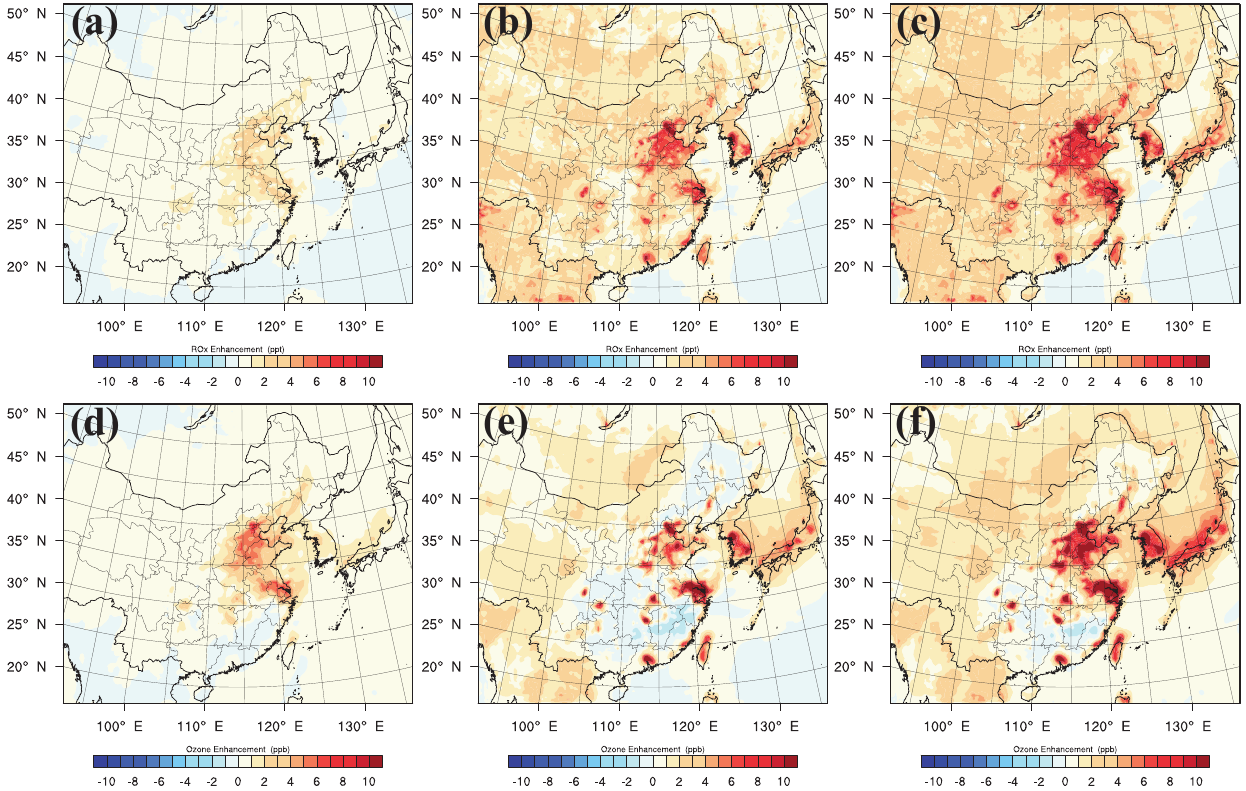
Figure 5. Daytime (06:00–18:00LT) RO x enhancements (ppt) in (a) ReNOM_Cl case, (b) ReNOM_HONO case, and (c) ReNOM case; O 3 enhancements (ppb) in (d) ReNOM_Cl case, (e) ReNOM_HONO case, and (f) ReNOM